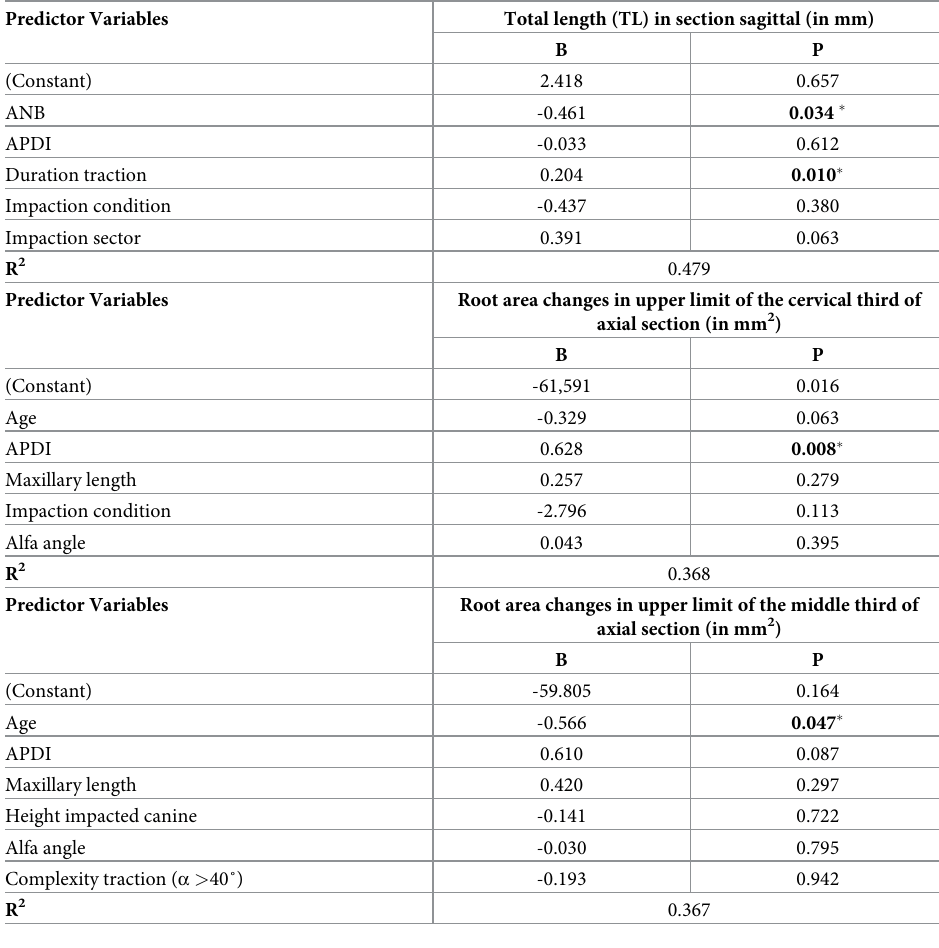
Table 6. Linear regression model to evaluate the influence of the predictor variables in the root changes of total length at sagittal section and root area changes at sagittal, and cervical and middle third at axial sections of